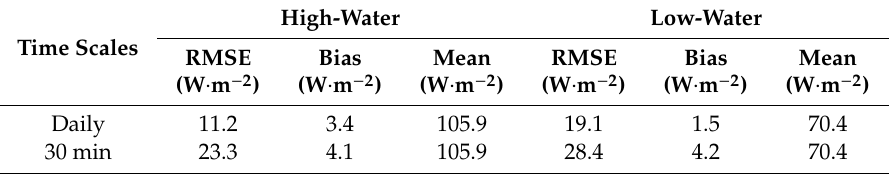
Table 5. Accuracy of the LE estimation using the PT equation ( α = 1.26) during both periods.